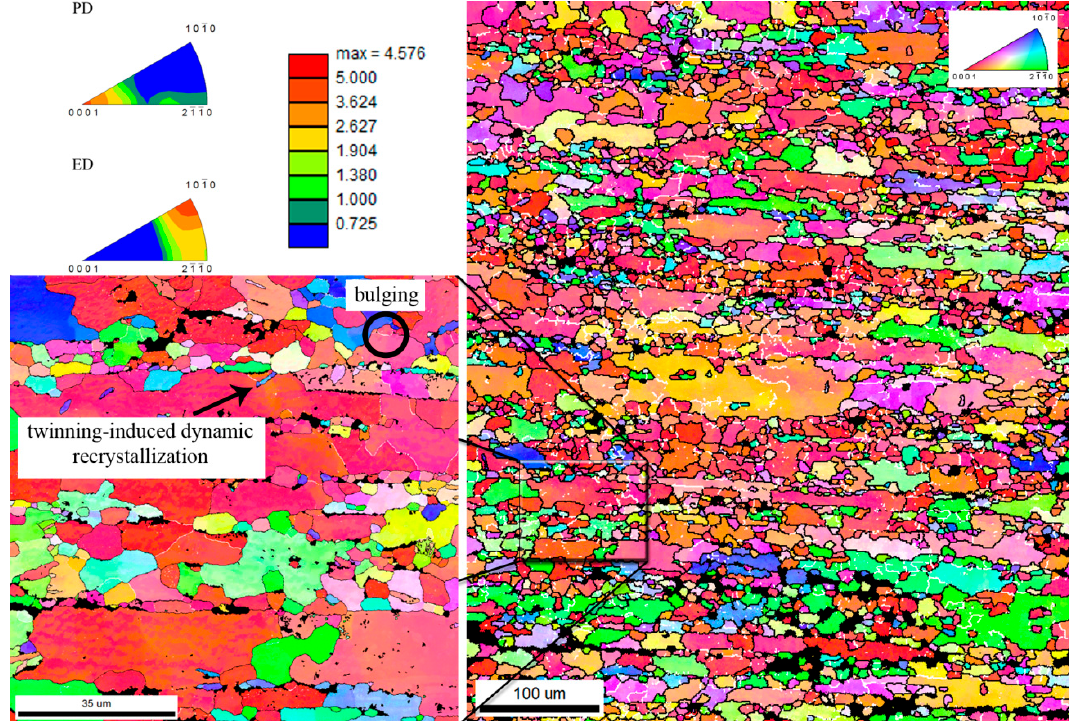
Figure 3. Inverse pole figures (IPF) and IPF maps (perpendicular direction (PD)) of pure zinc with characteristic signs of dynamic recrystallization.